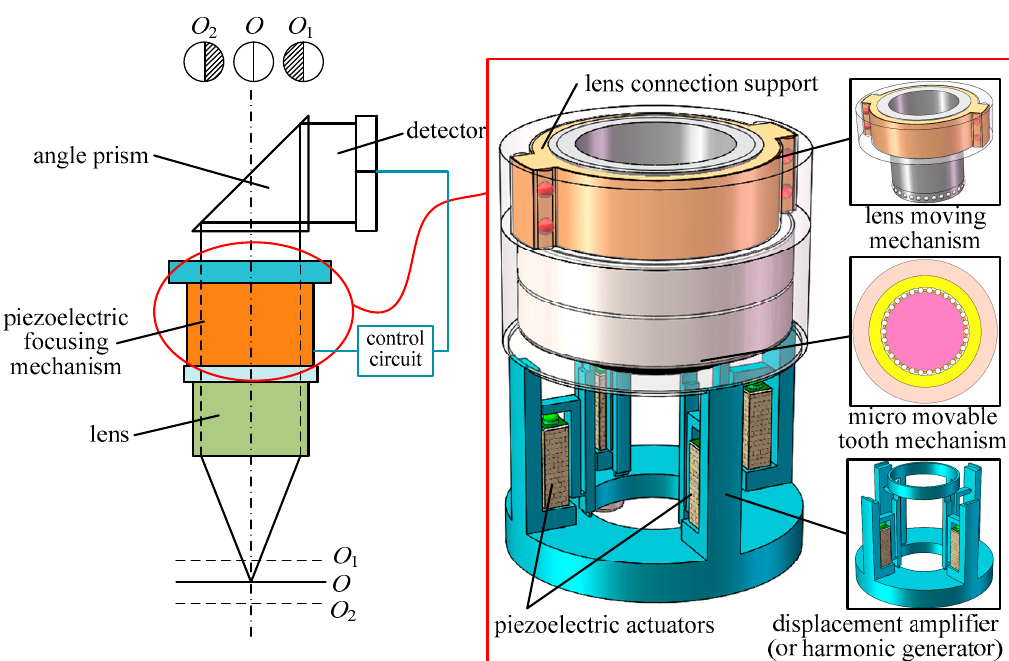
Figure 1. Operating principle of the piezo-driven focusing mechanism.